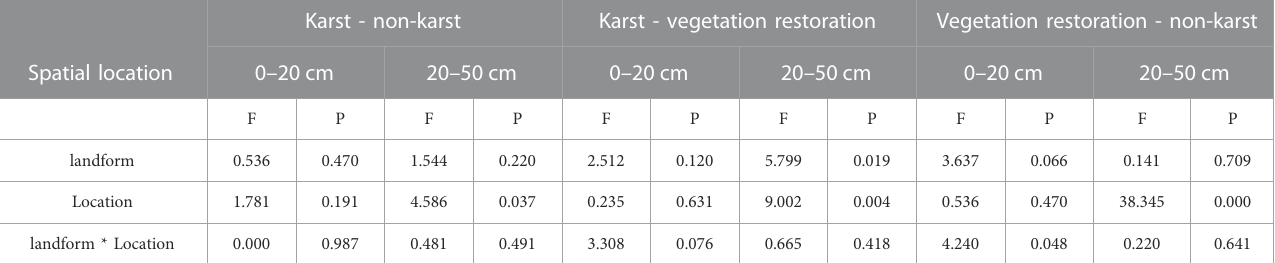
TABLE 5 Generalized linear mixed model (GLMM) analysis of soil ROC.